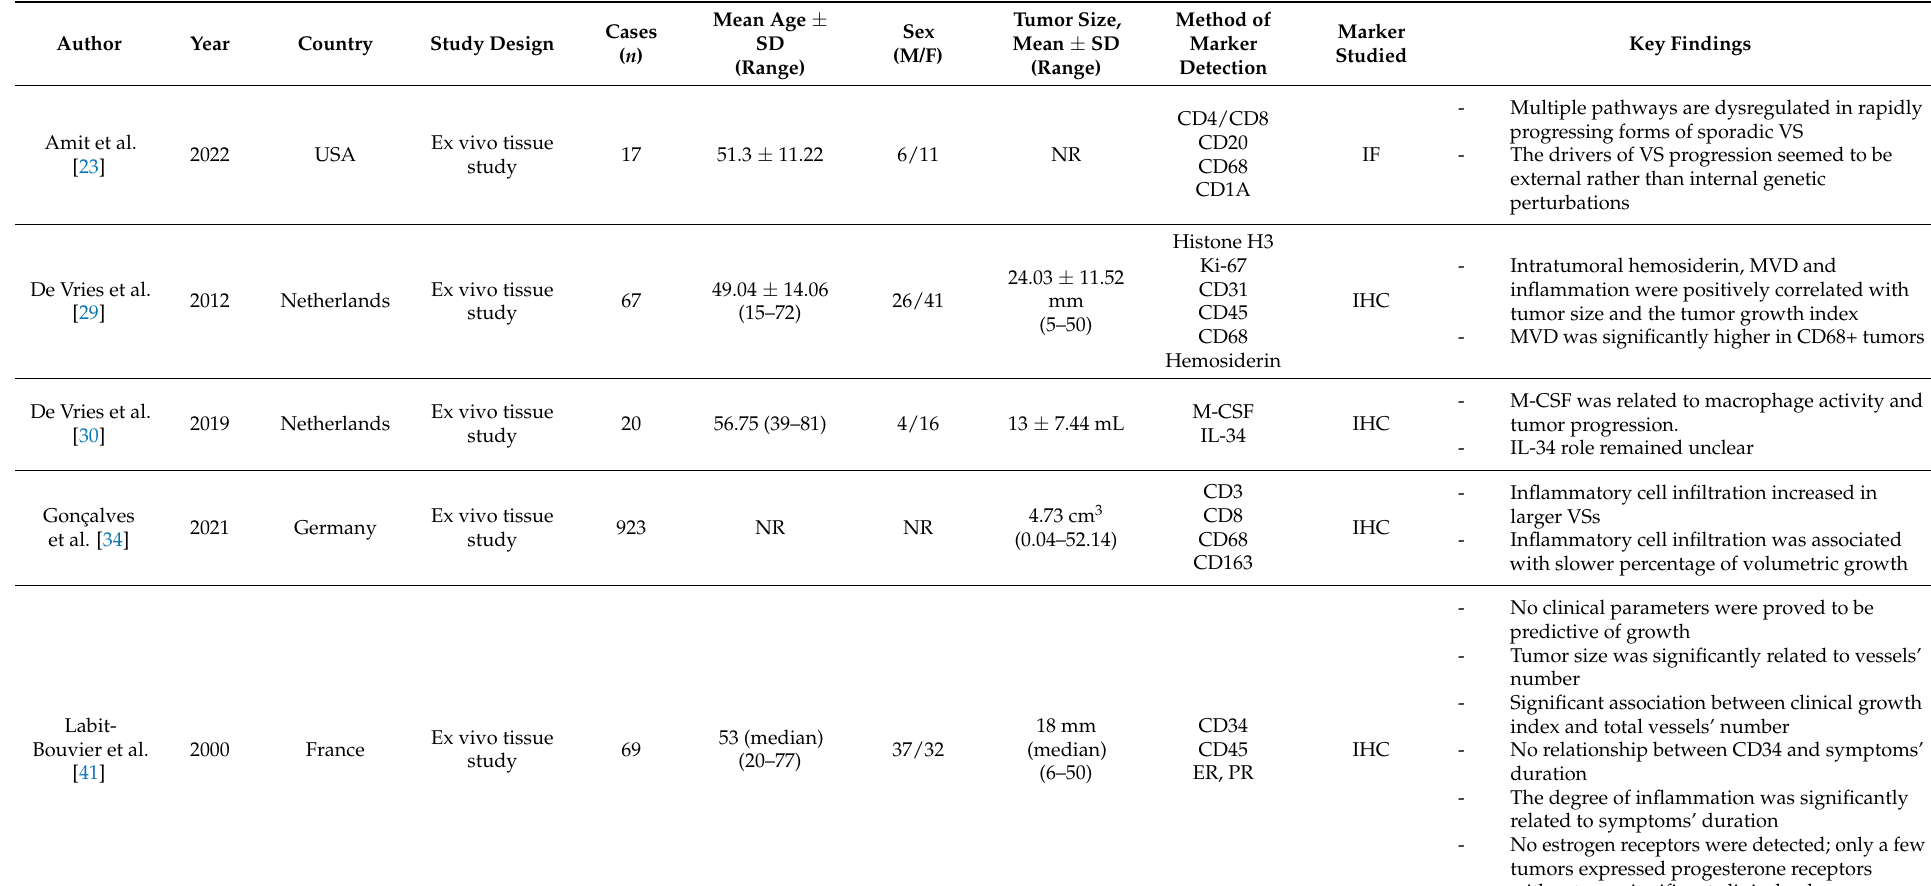
Table 2. Studies examining the role of immune cell populations in sporadic vestibular